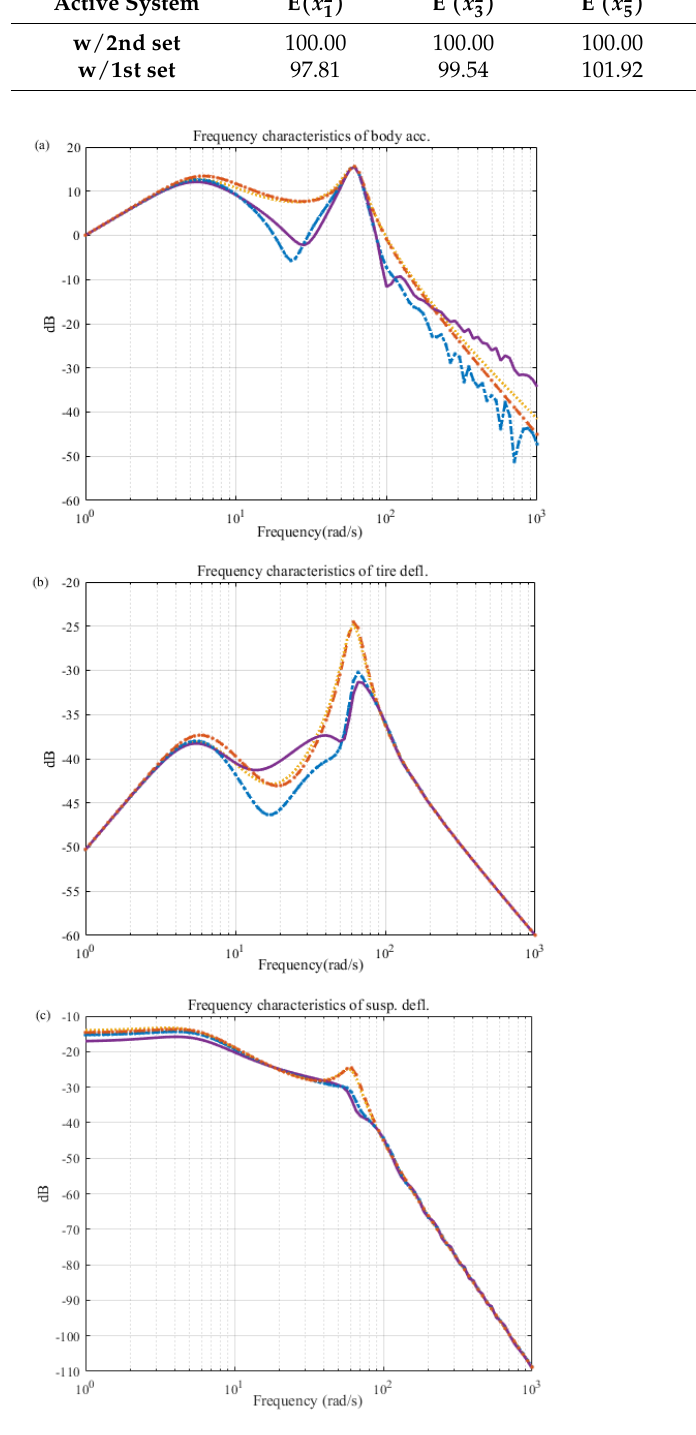
Figure 3. ( a – c ) Frequency characteristics of for active system with preview (0.1 s) and without